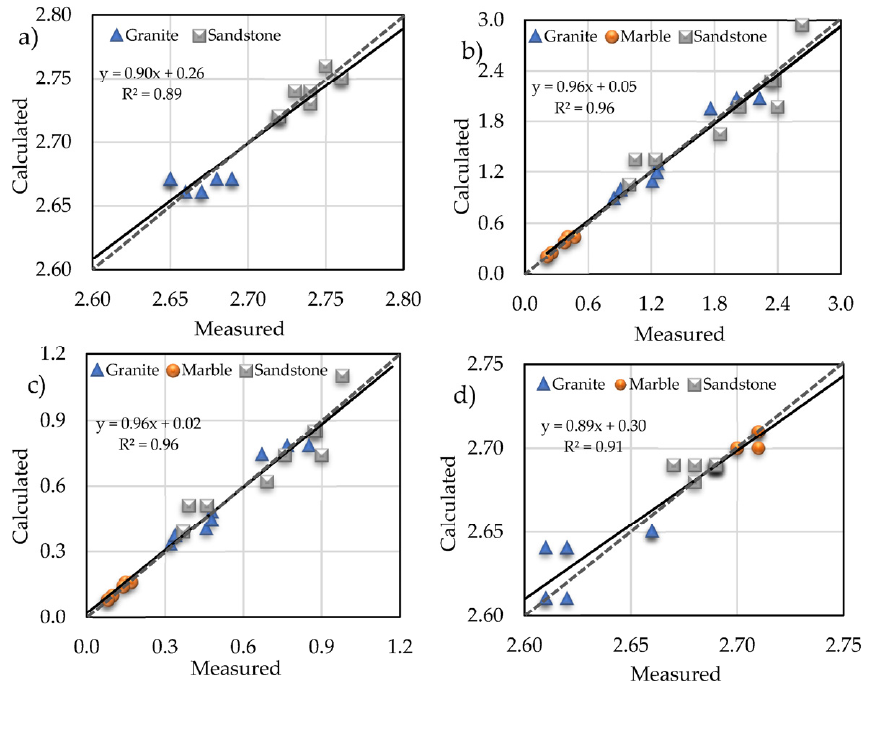
Figure 9. Measured and calculated values of physical properties of the studied rocks obtained from R dr -value ( a ) specific gravity, ( b ) porosity, ( c ) water absorption, and ( d ) dry density.